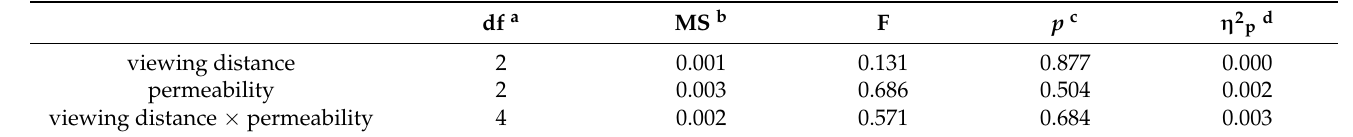
Table 5. Impacts of different viewing distances and permeability levels on (cid:52) E HR. df a